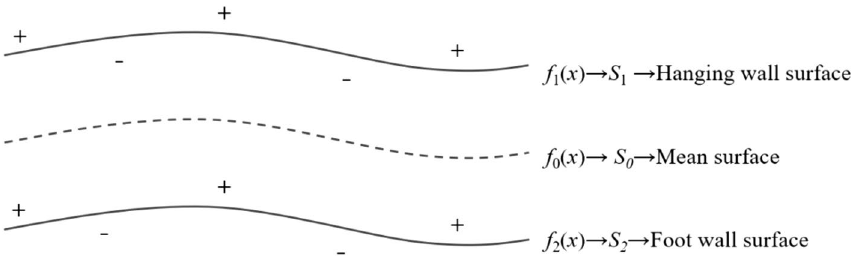
Figure 3. The implicit function fields of the hanging wall surface, the mean surface and the foot wall surface.